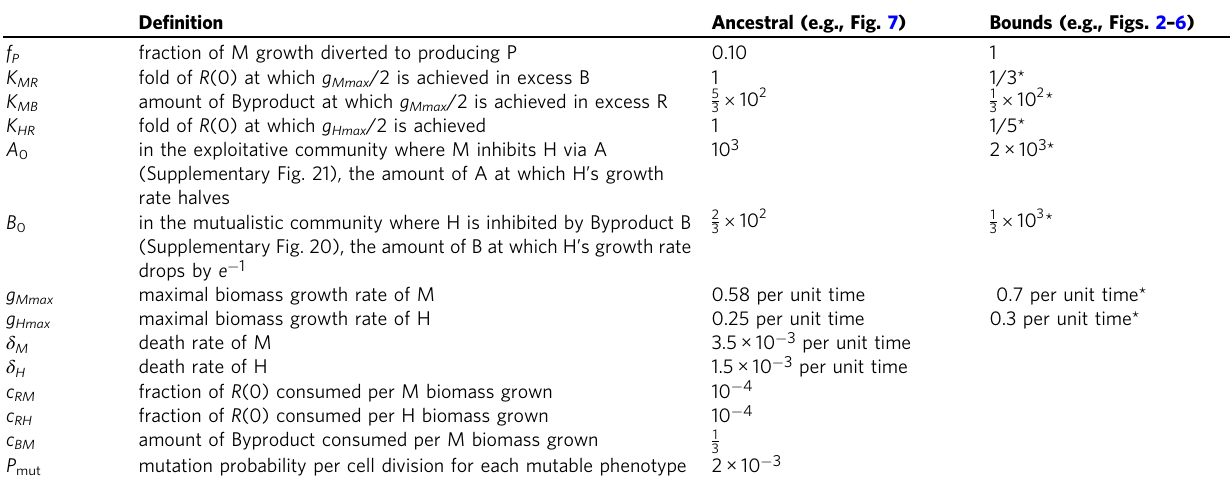
Simulations in Fig. 7 start with H and M whose genotypes (and thus phenotypes) are listed in the “ Ancestral ” column. These genotypes are not allowed to change beyond values listed in the “ Bounds ” column. In most simulations where only f P can be modi fi ed by mutations, except for f P , parameters in the Bounds column are used. For maximal growth rates, and H ’ s sensitivity to A and B ( A 0 and B 0 , respectively), * represents evolutionary upper bound. For K SpeciesMetabolite , * represents evolutionary lower bound, which corresponds to evolutionary upper bound for Species ’ s af fi nity for Metabolite (1/ K SpeciesMetabolite ). For parameter justi fi cations, see our previous work 15